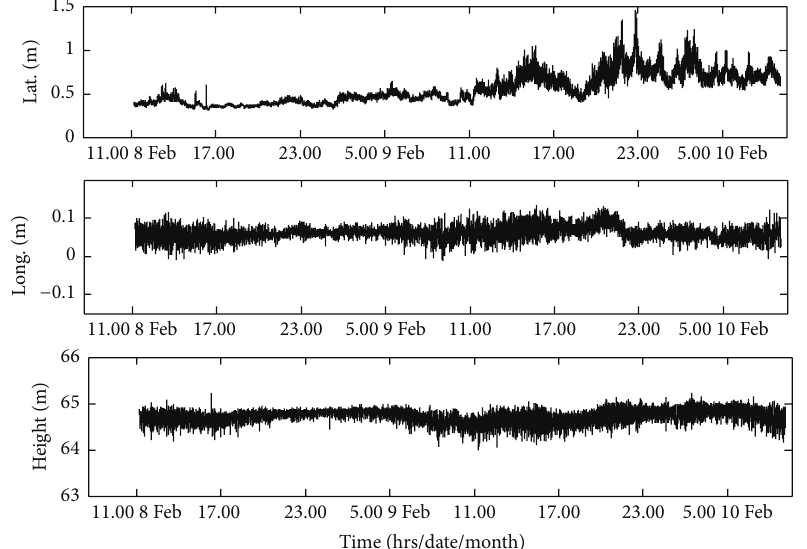
Figure 2: Lateral, longitudinal, and vertical deflection in BCS during the 46h